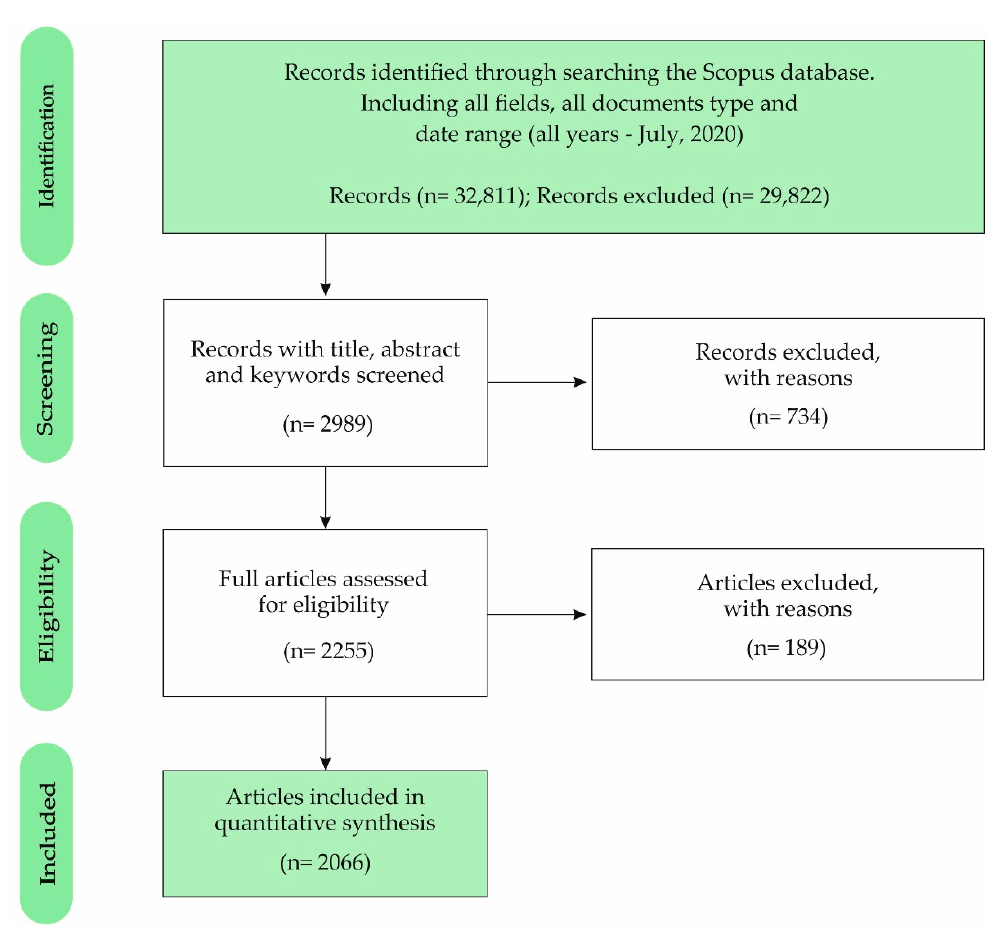
Figure 1. Flowchart: selection of the sample of articles based on Preferred Reporting Items for Systematic Reviews and Meta-Analyzes (PRISMA).